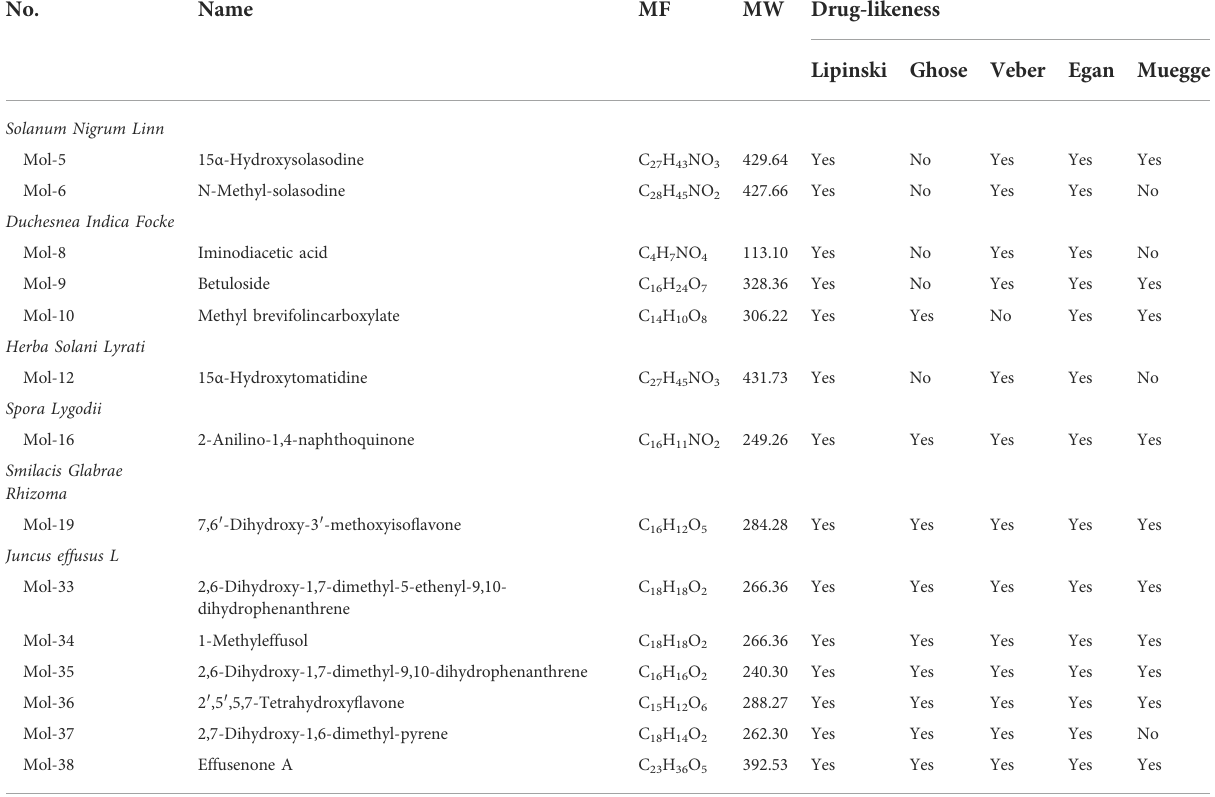
TABLE 2 Bioactive compounds retrieved from other two databases and through literature mining.